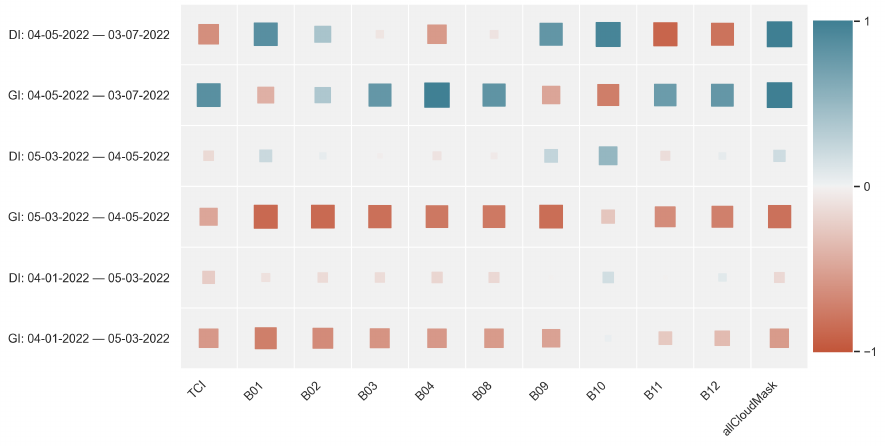
Figure 12. Example of 60-day window correlations.